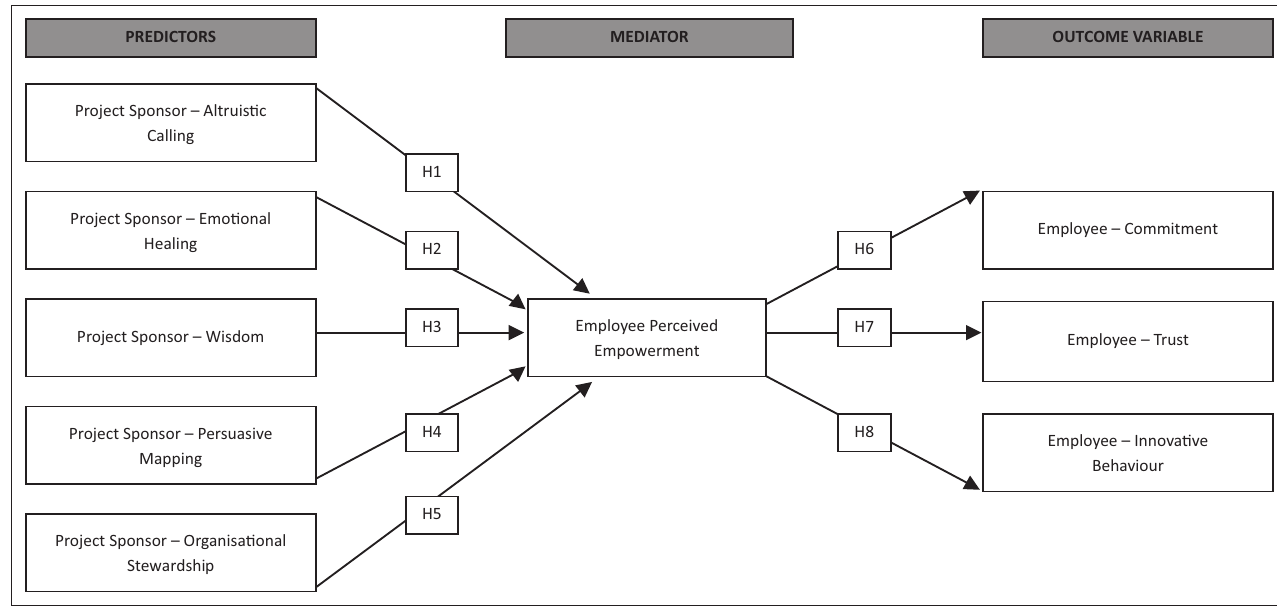
FIGURE 1: Hypothesised relationships and conceptual